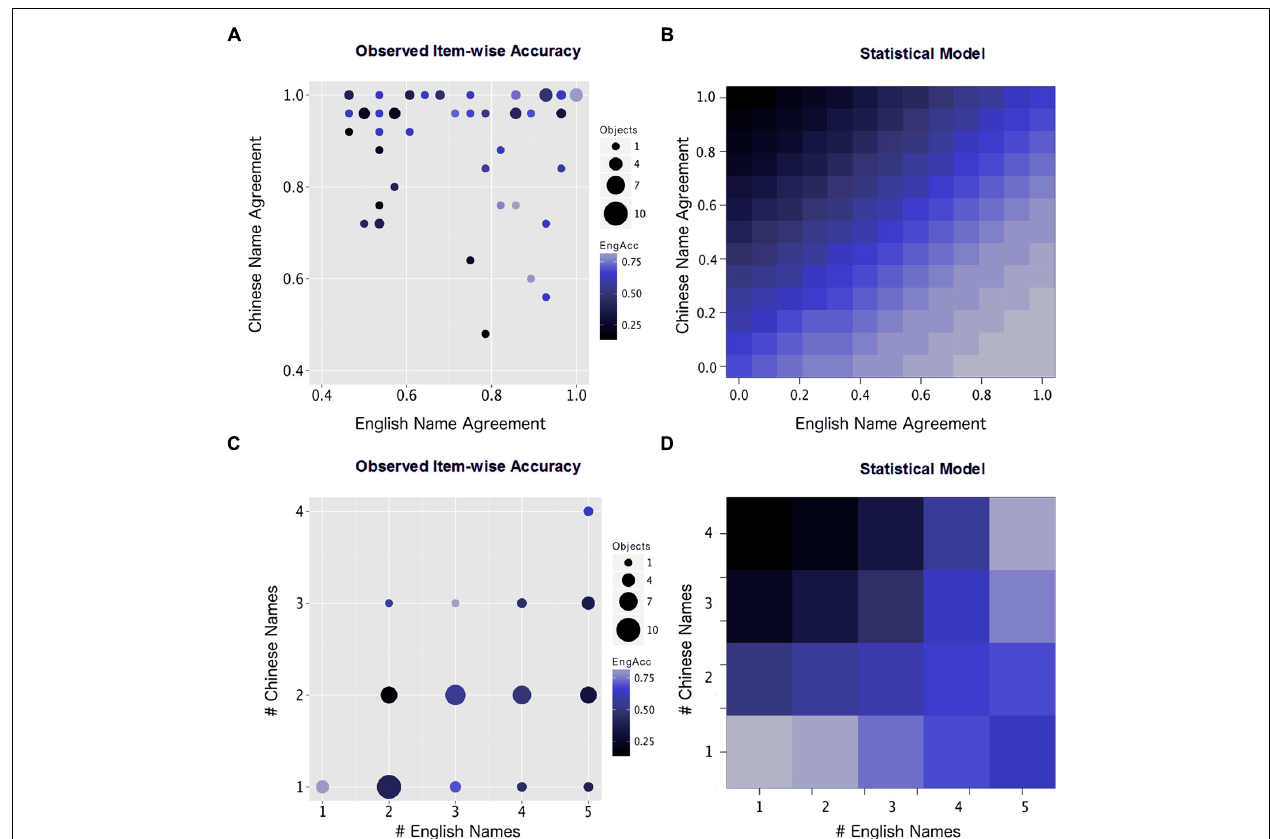
statistical model at varying levels of Chinese and English agreement, controlling for all learner variables and number of alternate names. (C) The interaction between the number of names generated by native speakers of Chinese and English as predictors of English naming accuracy by the Chinese–English bilinguals. (D) The accuracy values estimated by the statistical model at varying numbers of alternative names in Chinese and English, controlling for all learner variables and the level of native speaker